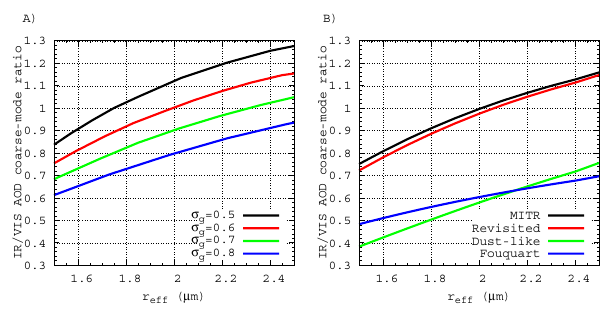
Figure A3. Theoretical IR/Vis AOD coarse-mode ratio as a func- tion of the effective radius (a) for the MITR model and the standard deviation of the width of the size distribution σ , (b) for σ = 0 . 6 and several refractive indices.